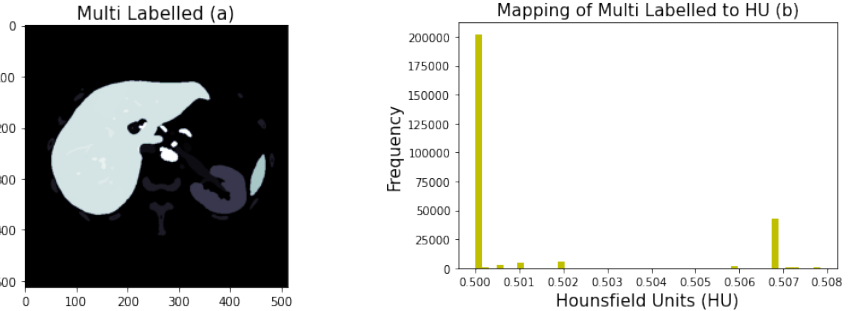
Figure 4. Multi segmented mask plot from ‘ LABELLED_DICOM ’ ( a ) and corresponding histogram of HU values ( b